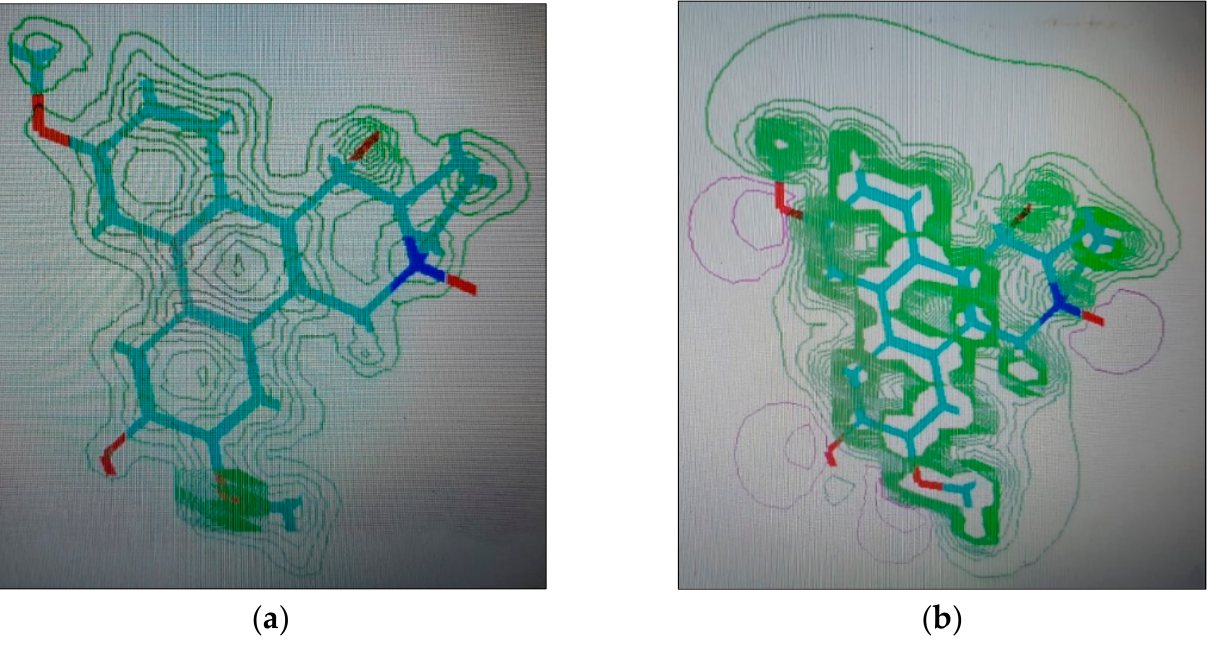
Figure 9. Structure ( 6 ) (tylophorinidine-N-Oxide), 2D renderings: ( a ) charge density localizations; ( b ) electrostatic potential.